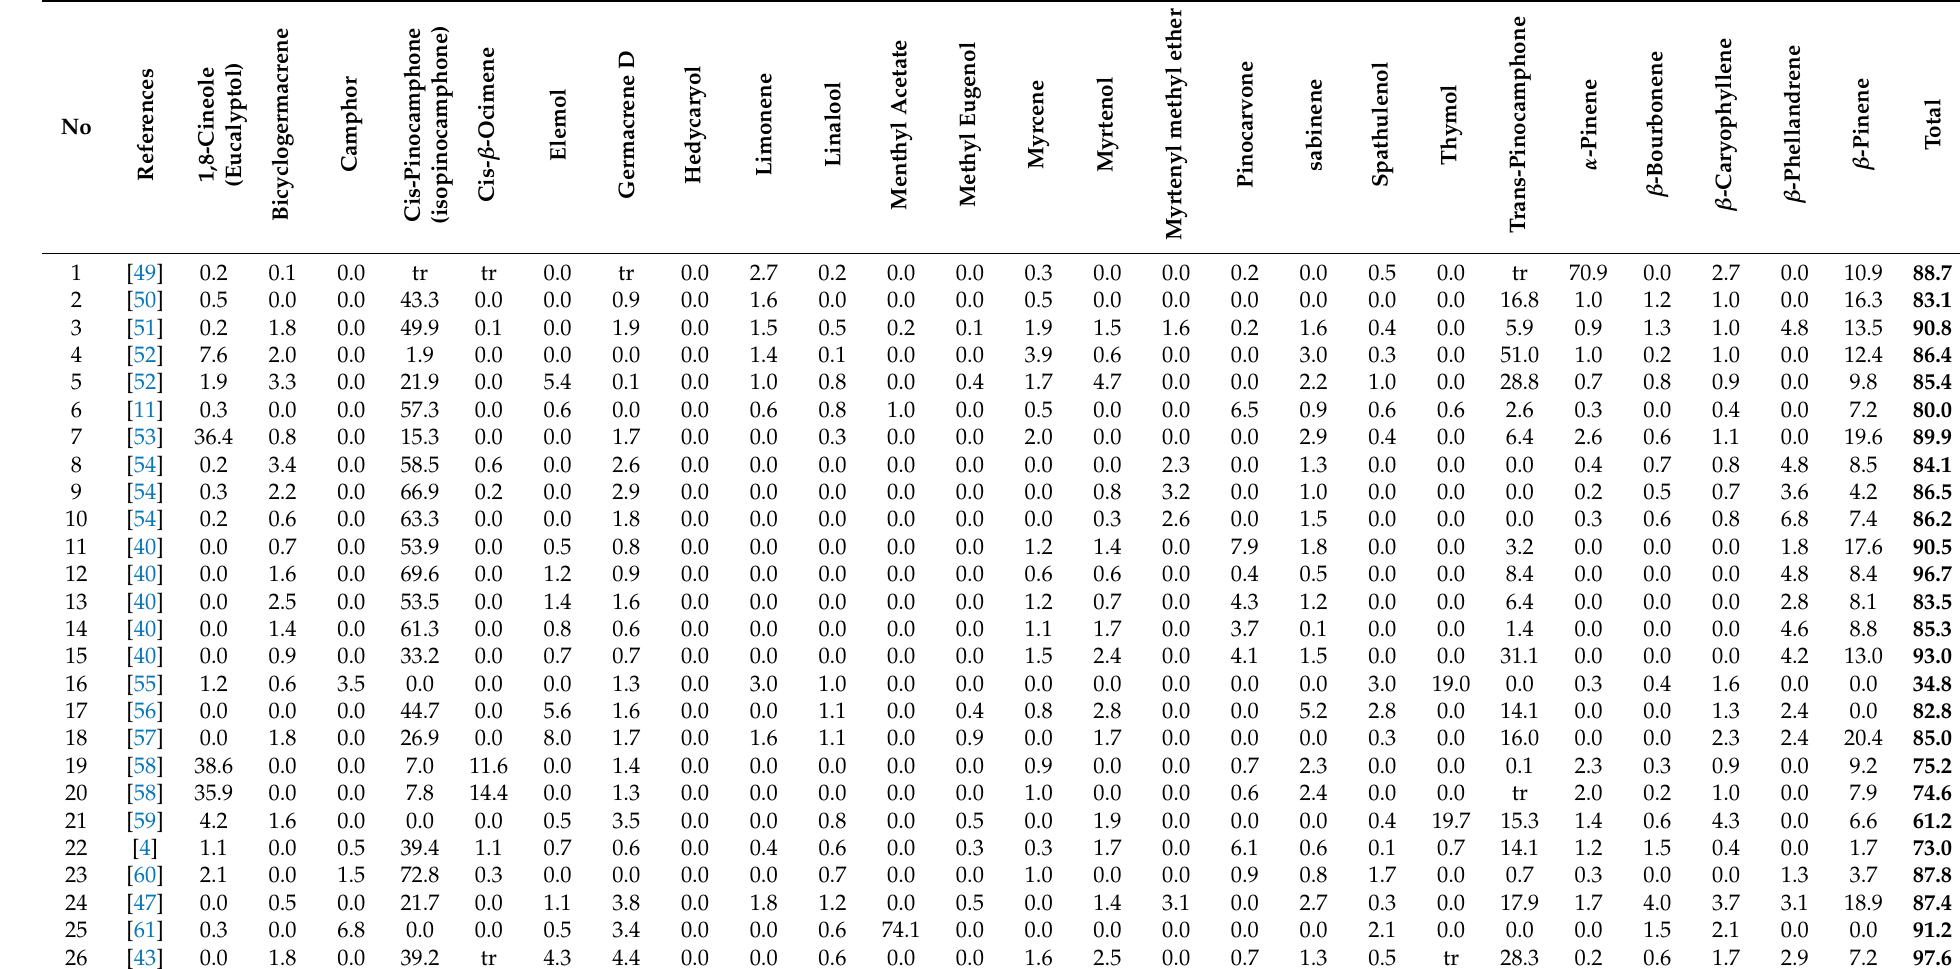
Table 4. Chemical composition of different hyssop accessions according to